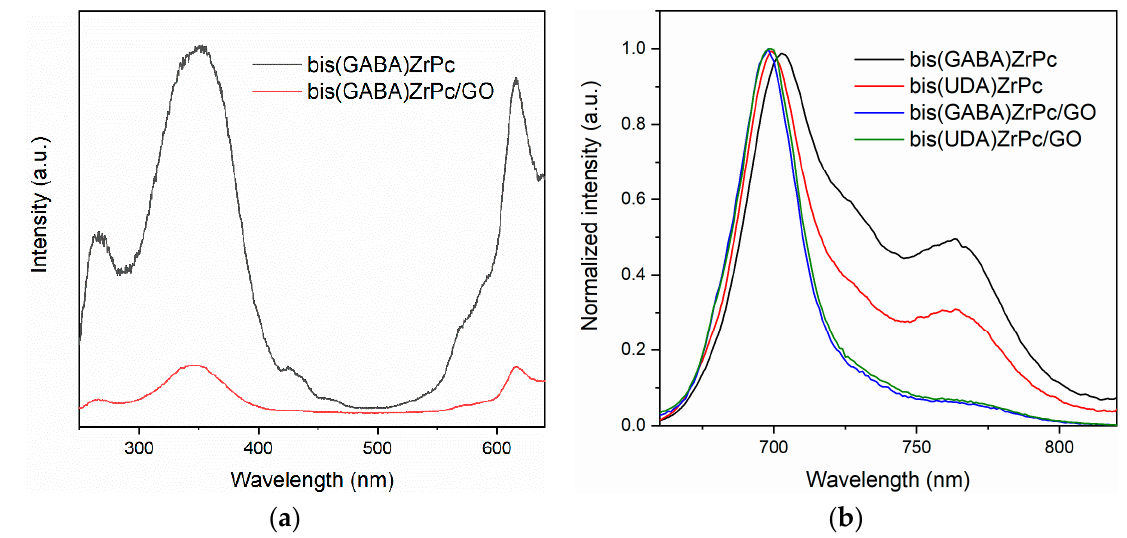
Figure 4. ( a ) Photoluminescence excitation spectra of bis(4-aminobutyrato)ZrPc before and after